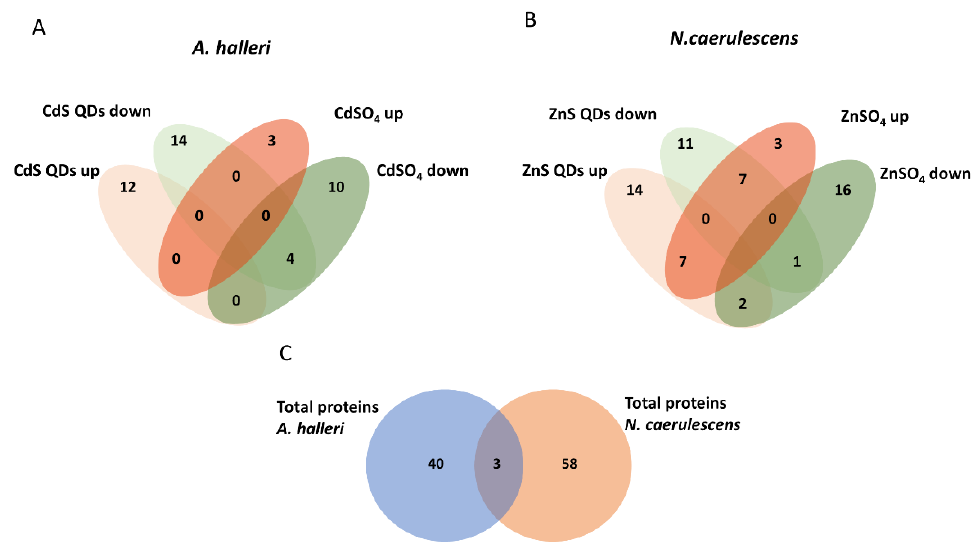
Figure 1. Representation of the effect of exposure to Cd (CdS QDs or CdSO 4 ) and Zn (ZnS QDs or ZnSO 4 ) on proteome. The Venn Diagrams stand for up and down-regulated proteins treated with Cd in A. halleri : ( A ) and treated with Zn in N. caerulescens ( B ). In ( C ), proteins in common between two hyperaccumulators are numerated.